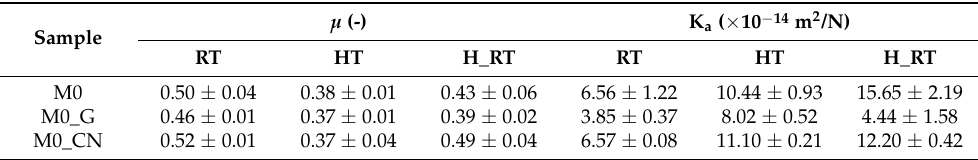
Table 4. Experimental results of the PoD tests at room temperature (RT), high temperature (HT) and at room temperature after the HT tests (H_RT): coefficient of friction ( µ ) and specific wear coefficient (Ka).